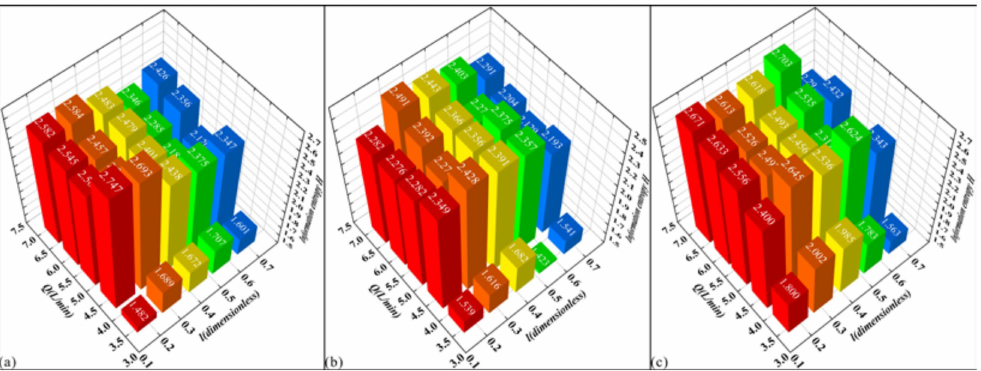
Figure 12. Calculation results of the information entropy of the two-dimensional flow field: ( a ) trian- gular prism; ( b ) semi-cylinder; ( c ) rectangular